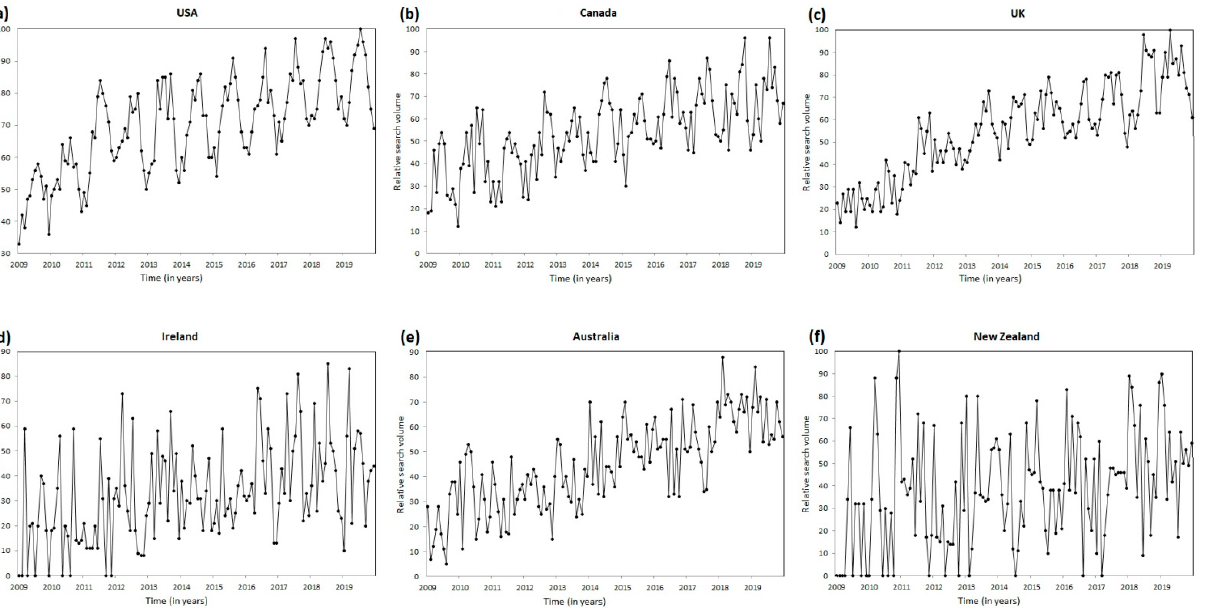
Figure 3. Time series plots for Google Trends search volume data for “plantar fasciitis” from January 2009 to December 2019 in ( a ) the USA, ( b ) Canada, ( c ) the U.K., ( d ) Ireland, ( e ) Australia, and ( f ) New Zealand.